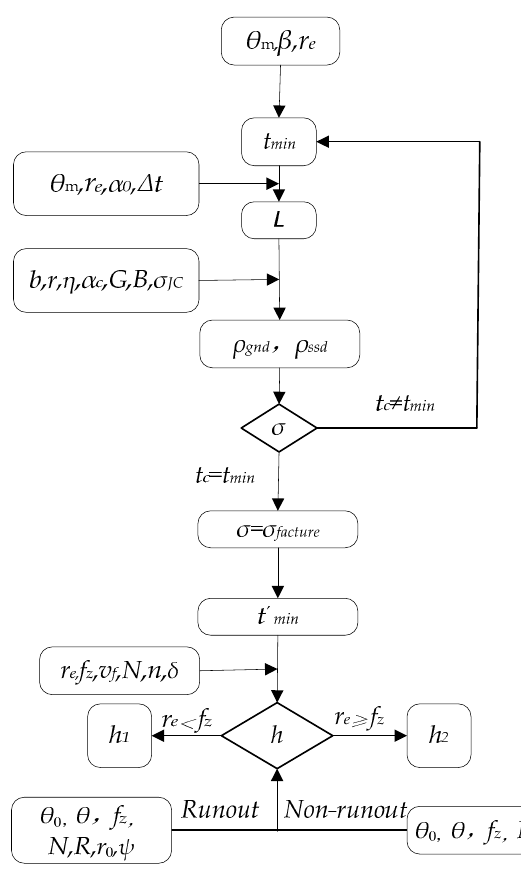
Figure 5. Flow chart of the surface model.